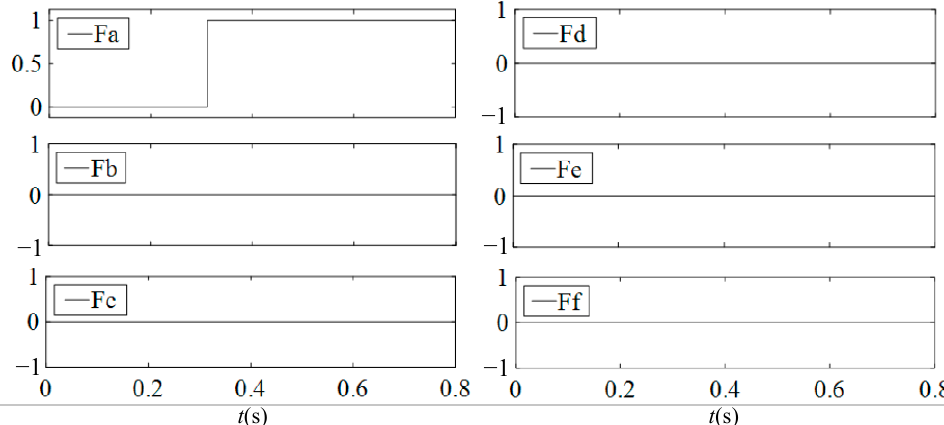
Figure 11. Phase a current waveform of open-circuit fault in 0.3 s. The fault index waveform under these conditions is shown in Figure 12. After 0.3 s, the phase a fault index rises to 1 and the fault indexes of other phases do not change.